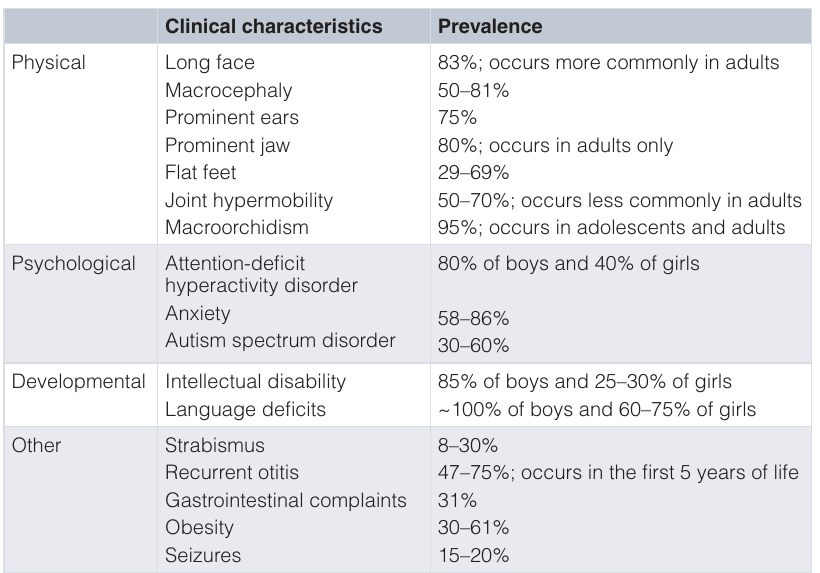
Table 1. Clinical features of fragile X